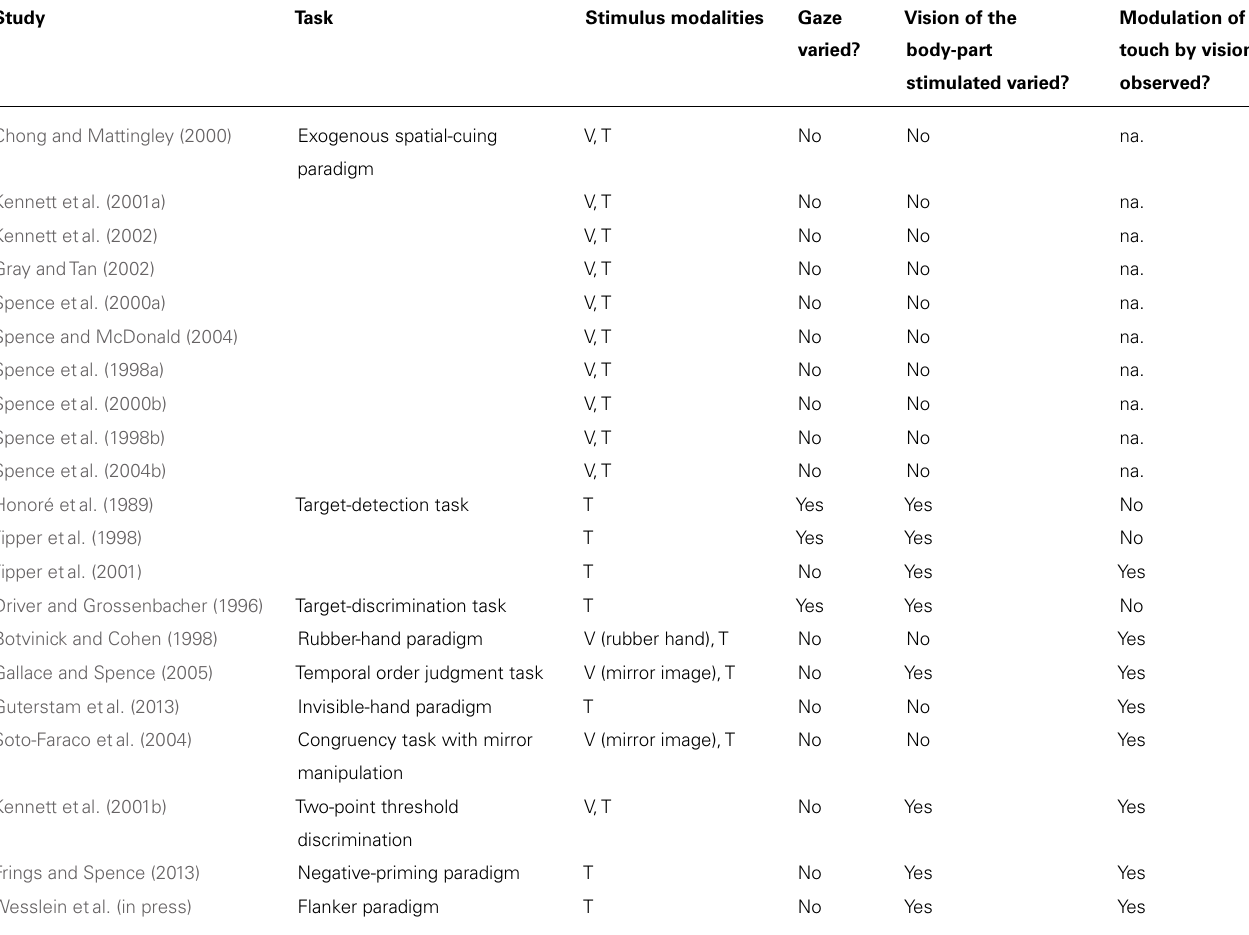
Table 1 | Summary table highlighting that, irrespective of the approach taken, most published studies have provided evidence in support of the existence of visuotactile